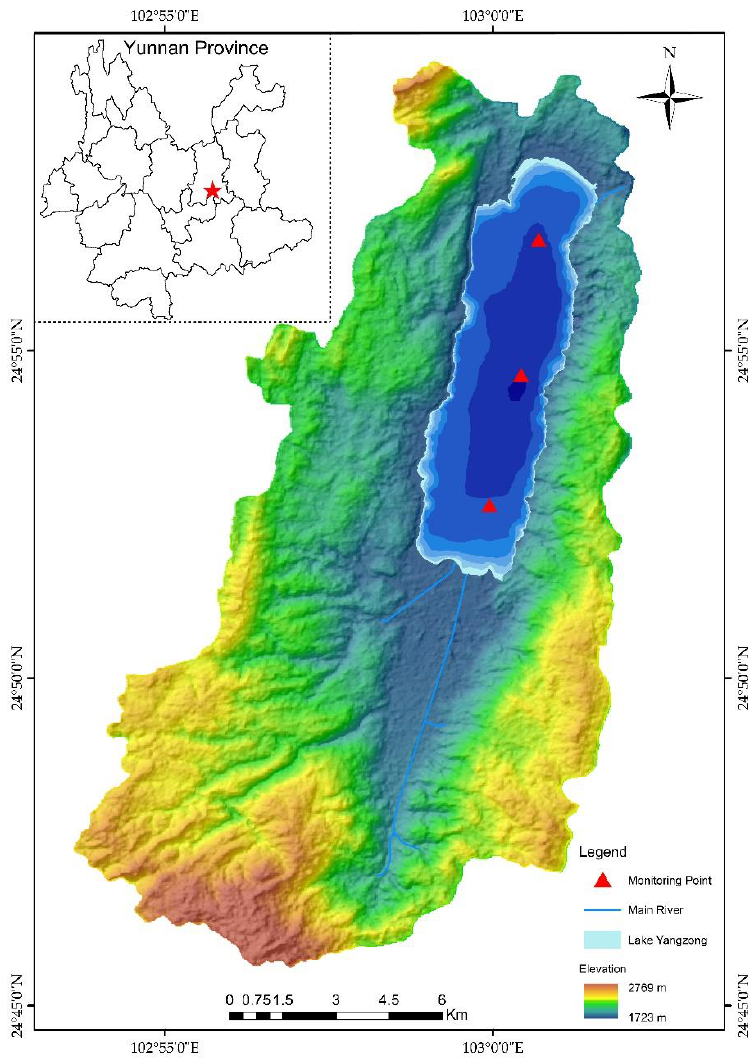
Figure 1. Study area and sampling sites of Lake Yangzong.